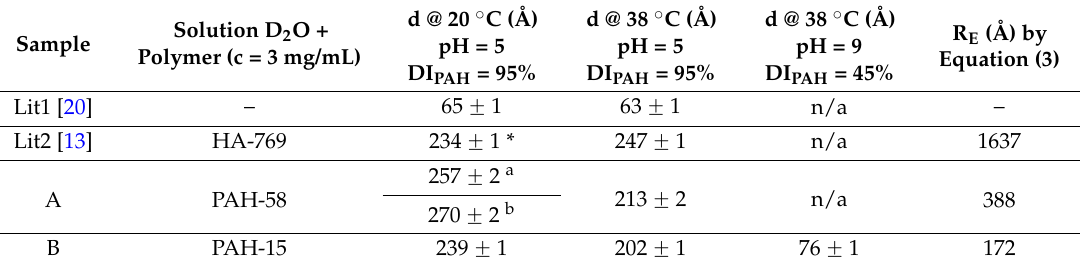
Table 3. d -spacings of oligolamellar DMPC bilayer stacks in polyelectrolyte